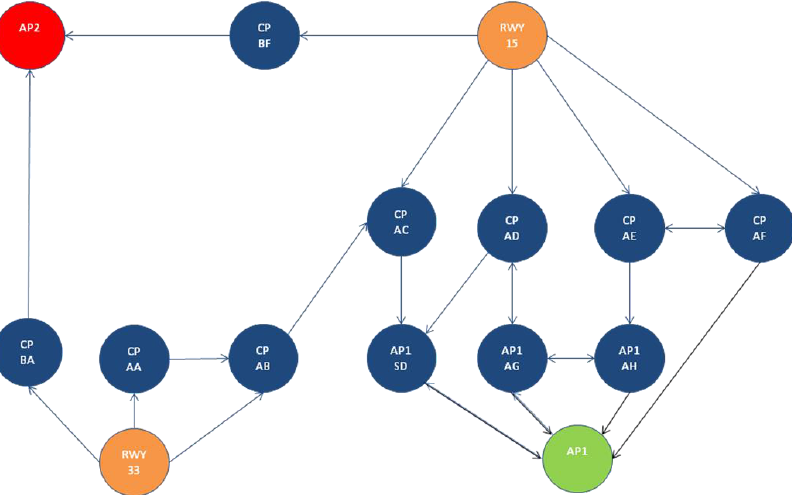
Figure 7. LIRA airport coding onto arrival ( top ) and departure ( bottom ) graphs for